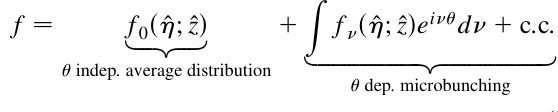
FIG. 7. (Color) Maximum FEL efficiency P the initial normalized rms energy spread (cid:6) quasilinear theory [46] (red solid curve) and from a simulation fitting formula [35] (green dashed